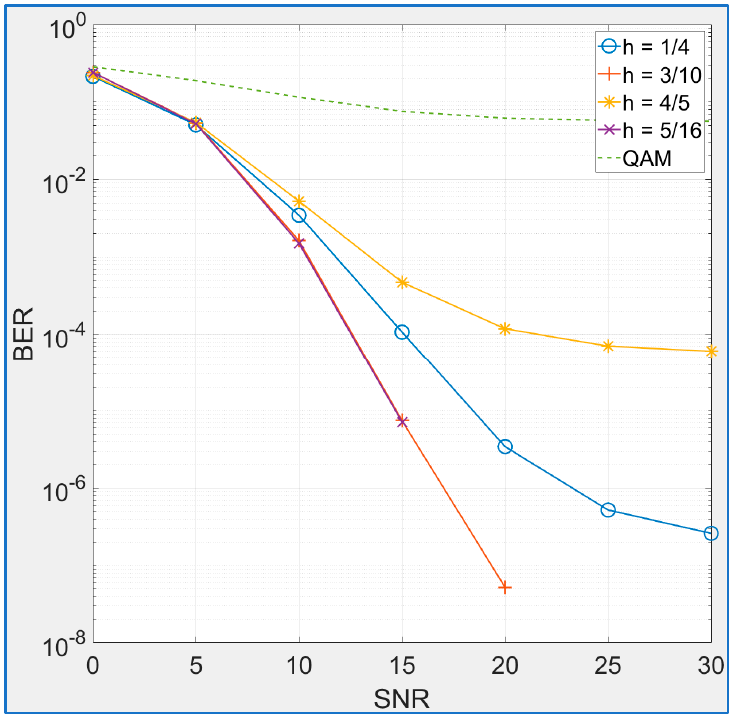
Figure 16. BER performance of CPM-GFDM vs. QAM-GFDM with 𝐽 = 8 for matched filter receiver over frequency-selective channels.